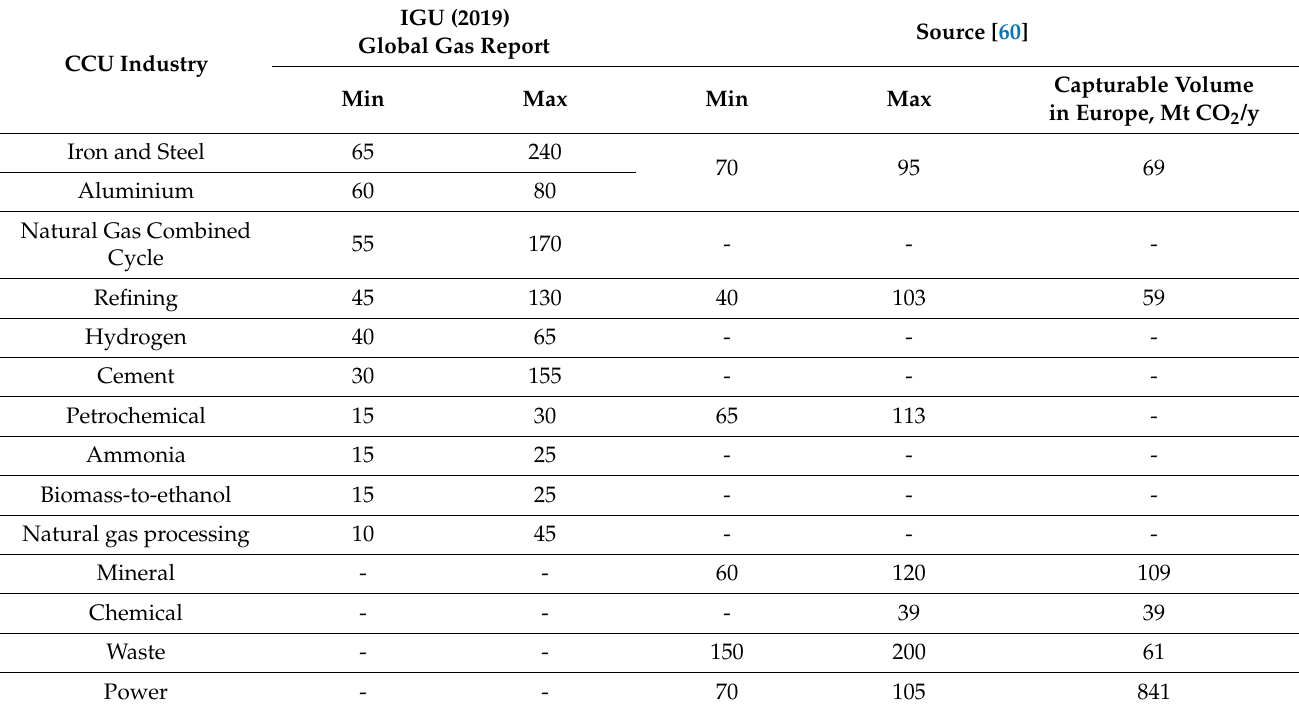
Table 2. Approximate cost of CCU, USD/t CO 2.